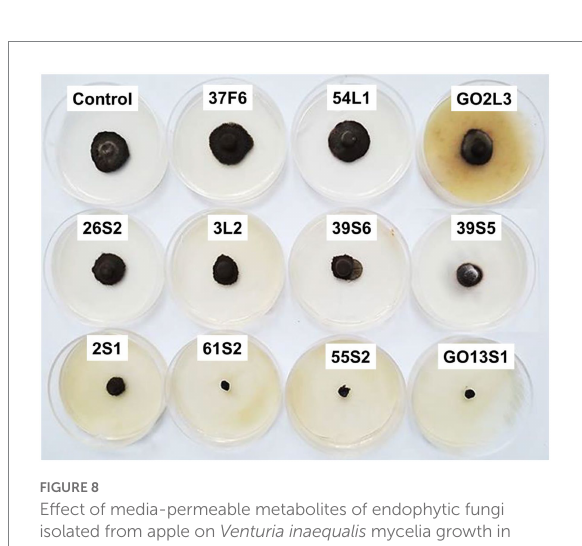
FIGURE 8 Effect of media-permeable metabolites of endophytic fungi isolated from apple on Venturia inaequalis mycelia growth in comparison to control after 1 month in vitro